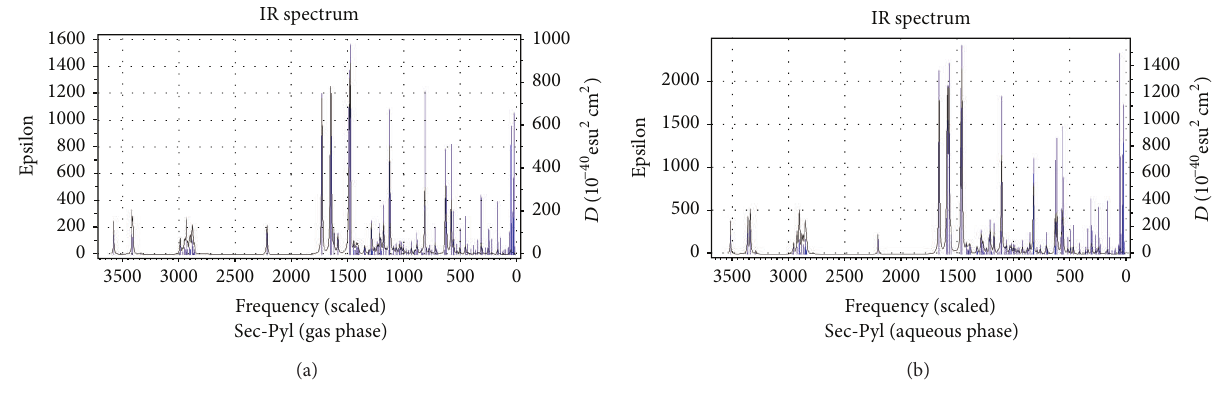
Figure 7: Vibrational spectra of Sec-Pyl in gas and aqueous